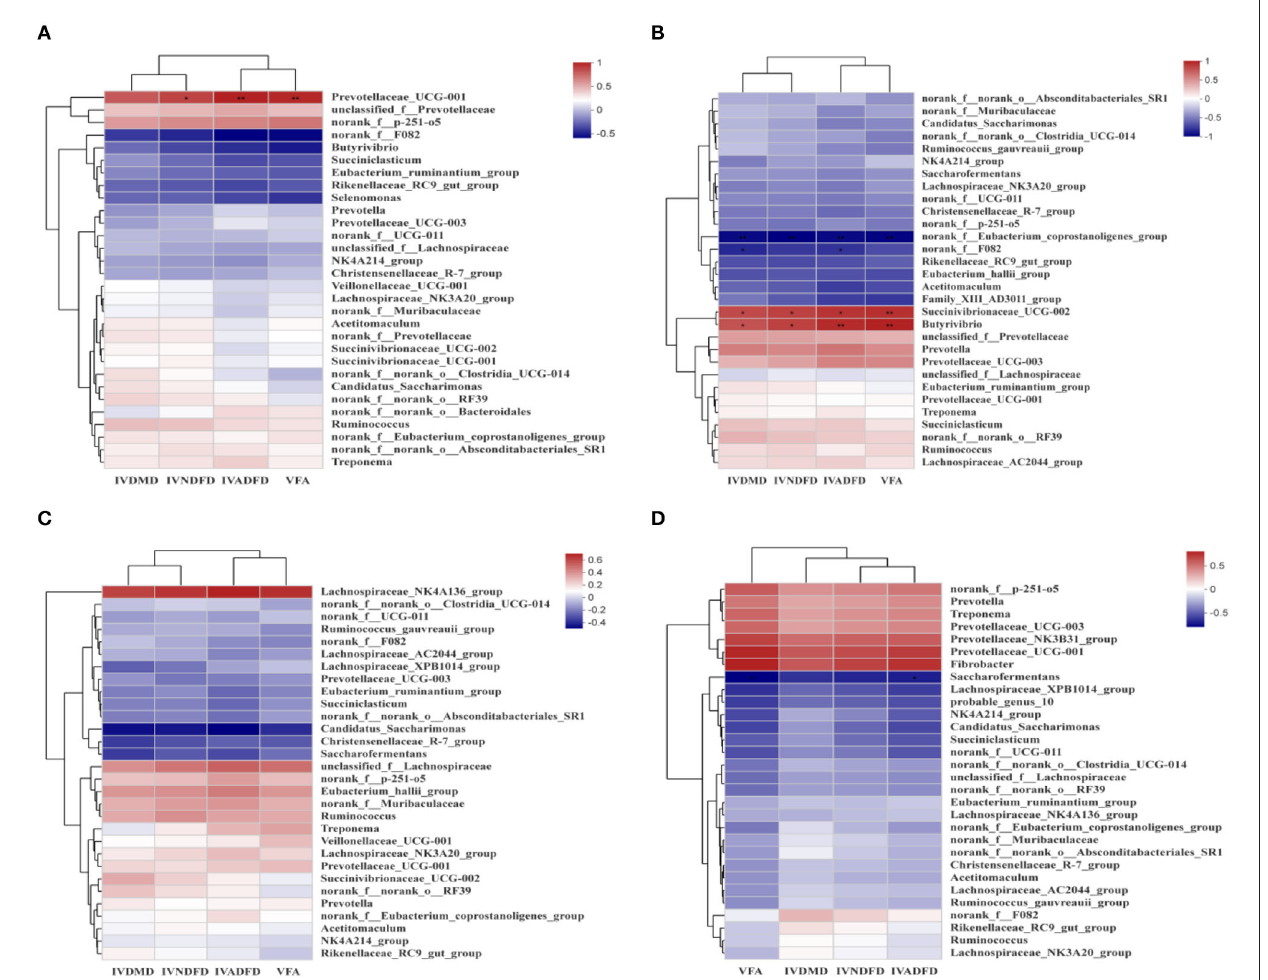
FIGURE 9 | Correlations heatmap of top 30 genera in colonization on surface of rice straw during incubation in rumen 0.5h (A) , 4h (B) , 12h (C) , and 24h (D) and environmental factors. Con, no additive, control; MA, added microecological agents; MA + M, a combination of microecological agents and molasses. *, **, and *** indicate the significant correlations at P < 0.05, 0.01, and 0.001. VFA, total volatile fatty acids; IVDMD, in vitro dry matter degradability; IVNDFD, in vitro neutral detergent fiber degradability; IVADFD, in vitro acid detergent fiber